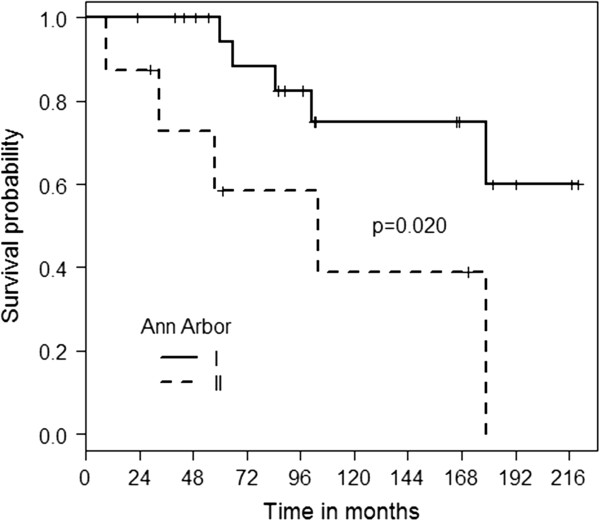
OS for patients with Ann Arbor stage 1 and 2